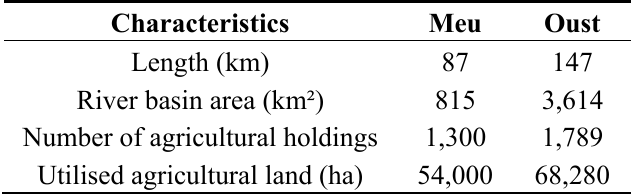
Table 1. Characteristics of the main sub watersheds of the